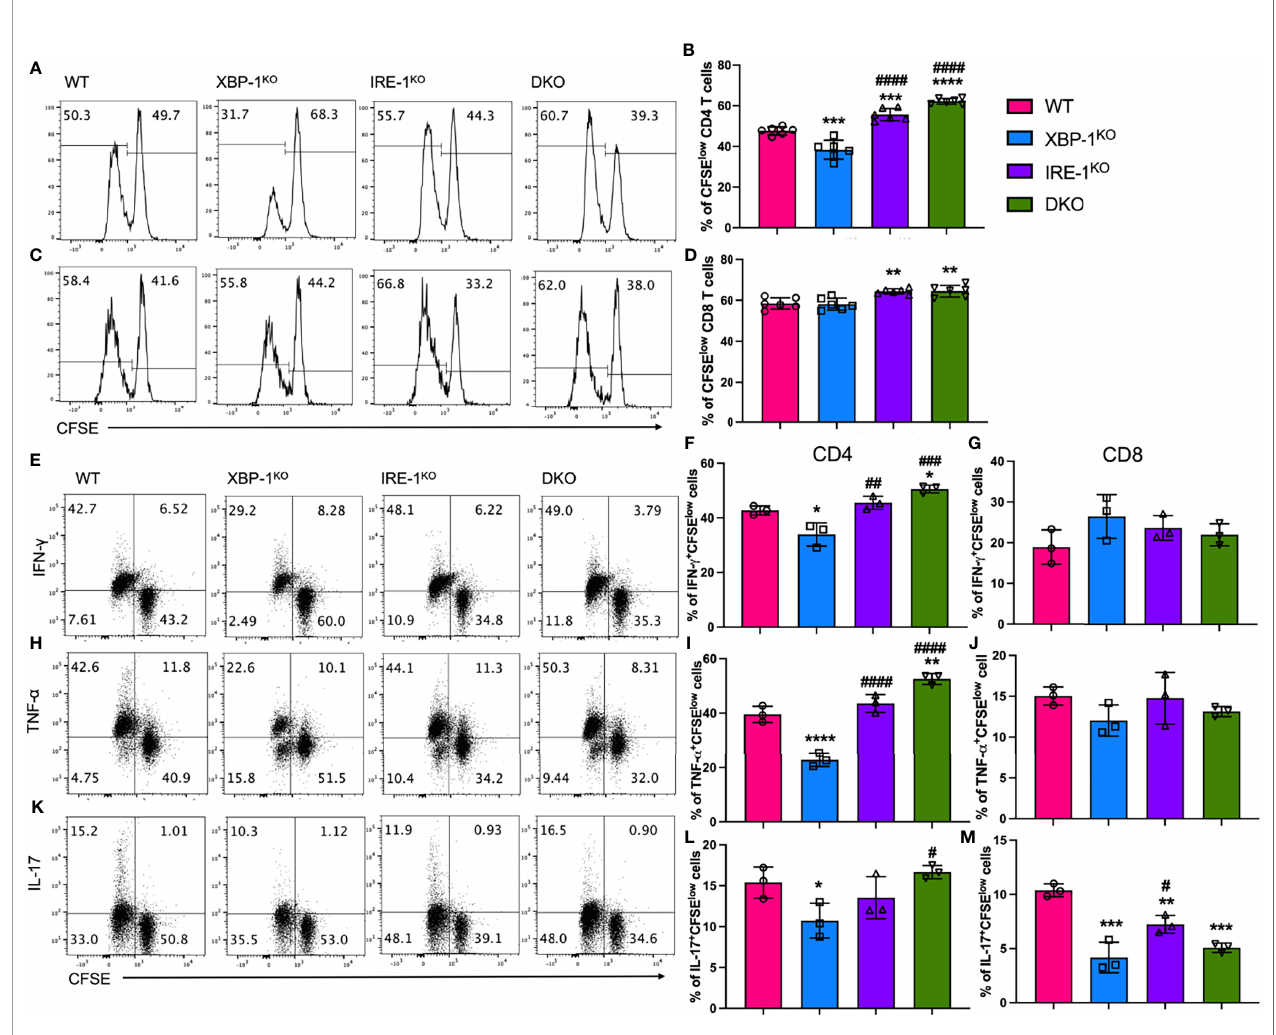
FIGURE 2 | Effects of XBP-1s and IRE-1 a on B cell ability to stimulate allogeneic T cells in vitro . B cells isolated from WT, XBP-1 KO , IRE-1 a KO , and DKO on B6 background mice are stimulated with 1 m g/ml LPS and 10 ng/ml IL-4 for 24 hrs. T cells were isolated from FVB mice and labeled with CFSE and then incubated with activated B cells for another 4 days. The representative fl ow panels of CFSE dilution and percentages of CFSE diluted cells on CD4 (A, B) and CD8 (C, D) T cells. T cells were stimulated with PMA and Ionomycin for 4 h before intracellular cytokine staining for cytokine detection. The representative fl ow panels and the percentages of IFN- g (E – G) , TNF- a (H – J) or IL-17 (K – M) among proliferated (CFSE low ) CD4 and CD8 T cells were shown. Data show representative fl ow cytometry plots and graphs from three independently repeated experiments. Statistics were performed using ordinary one-way ANOVA with Tukey ’ s multiple comparison test. *p < 0.05, **p